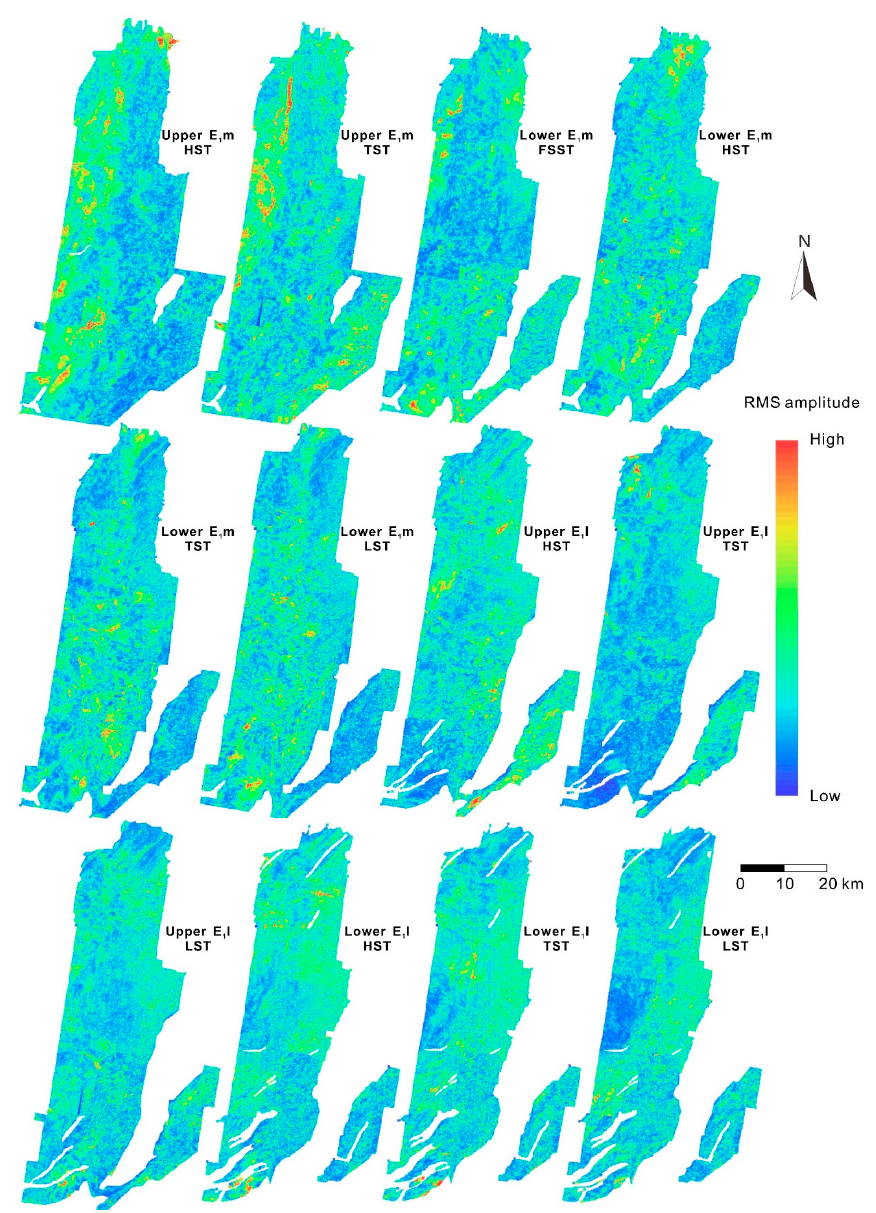
Figure 6. The calibrated porosity versus depth curve using Athy’s Law for the sandstone and siltstone in E 1 m and E 1 l (the curves for upper and lower layers are separated).